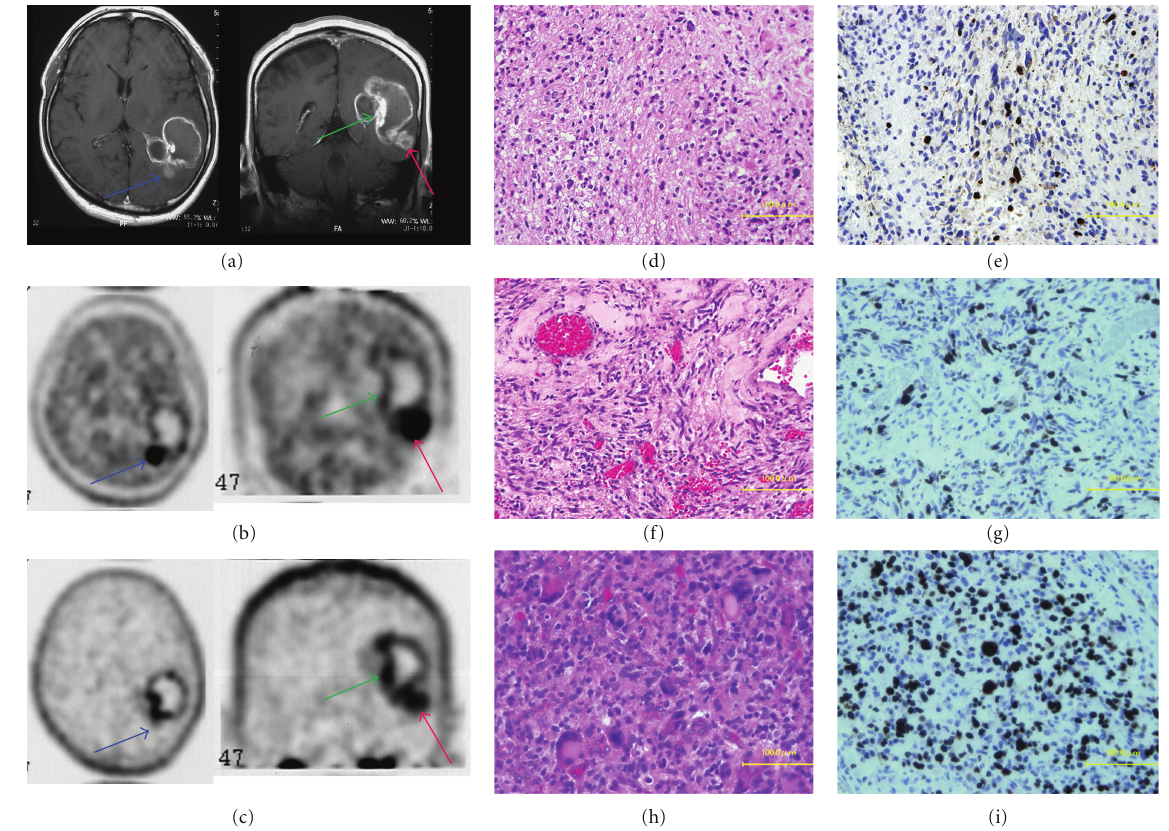
Figure 5: A 51-year-old man with glioblastoma. MRI clearly showed a ringed enhancement in the left temporo-occipital lobe (a). Areas of di ff erent enhancement and uptake between MET (b) and FLT (c) are projected on the tumor, in order to perform histological sampling for further correlation during the resection (blue arrow, green arrow, red arrow). Sample from the blue arrow demonstrates glioblastoma with oligodendroglioma (d) within high T / N ratio of MET-PET (4.31) and low T / N ratio of FLT-PET (3.24). Sample from the green arrow demonstrates necrosis area (f) within low T / N ratio of MET-PET (1.60) and high T / N ratio of FLT-PET (5.72). Sample from the red arrow demonstrates glioblastoma with multiple nuclear and large cells (h) within high T / N ratio of MET (3.27) and FLT-PET (5.28). Ki-67 index was 30% for the blue arrow (e), less than 10% for the green arrow (g), and 70% for the red arrow (i). Taken together, increased accumulation of both tracers (MET and FLT) appears to indicate high-grade